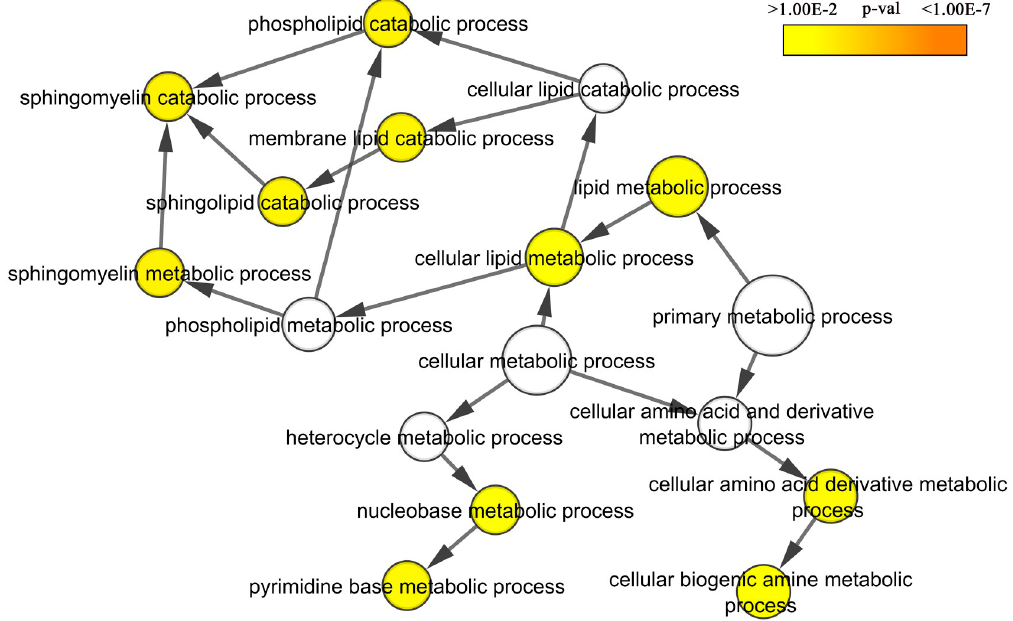
Fig 3. Gene ontology biological process term enrichment analysis for down-regulated LB-flies